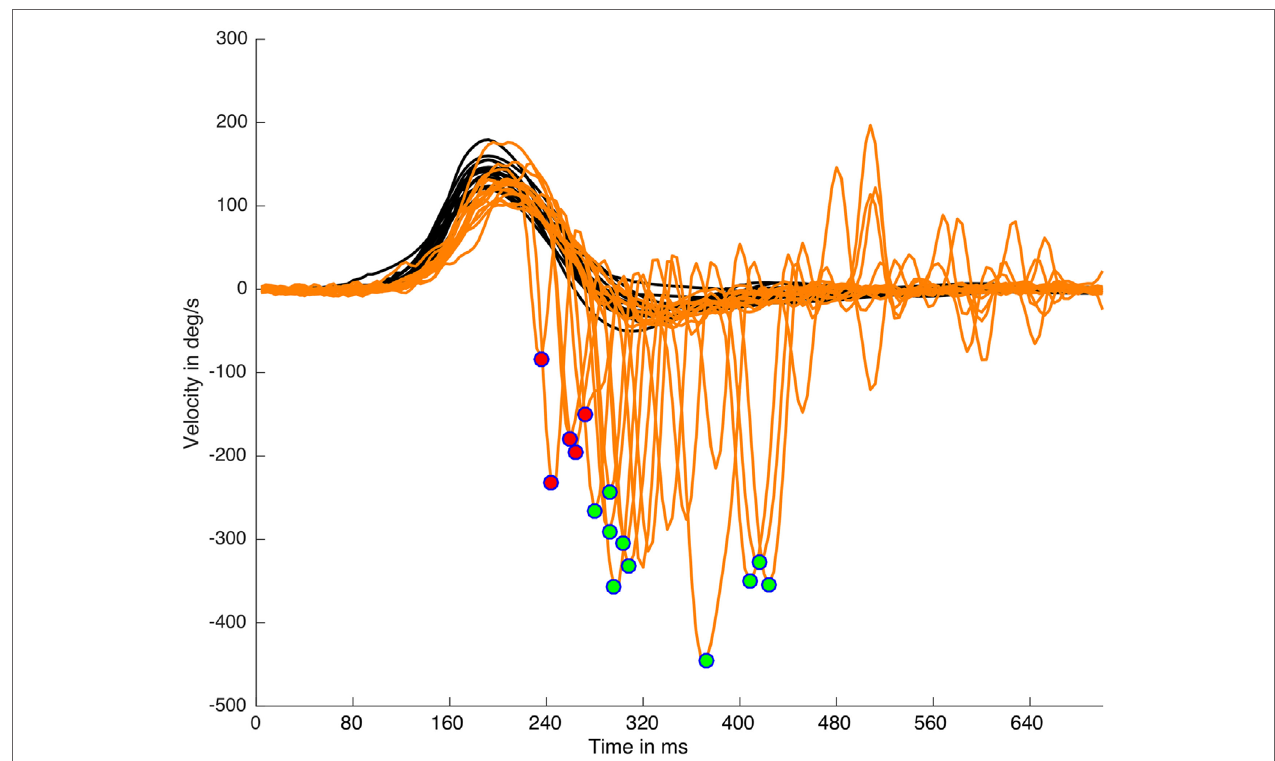
FigUre 2 | Suppression head impulse paradigm (SHIMP) saccades detection and classification on a real data (left side) plot processed with HITCal. After the specific SHIMP saccades detection an algorithm based on head impulse weight classified these saccades as early SHIMP saccades (marked with red circles) or not early SHIMP saccades (marked with green circles) depending if they exceed or not exceed the head impulse time window. Only one saccade is detected and classified per each head impulse. Black lines are head impulses, orange lines are eye